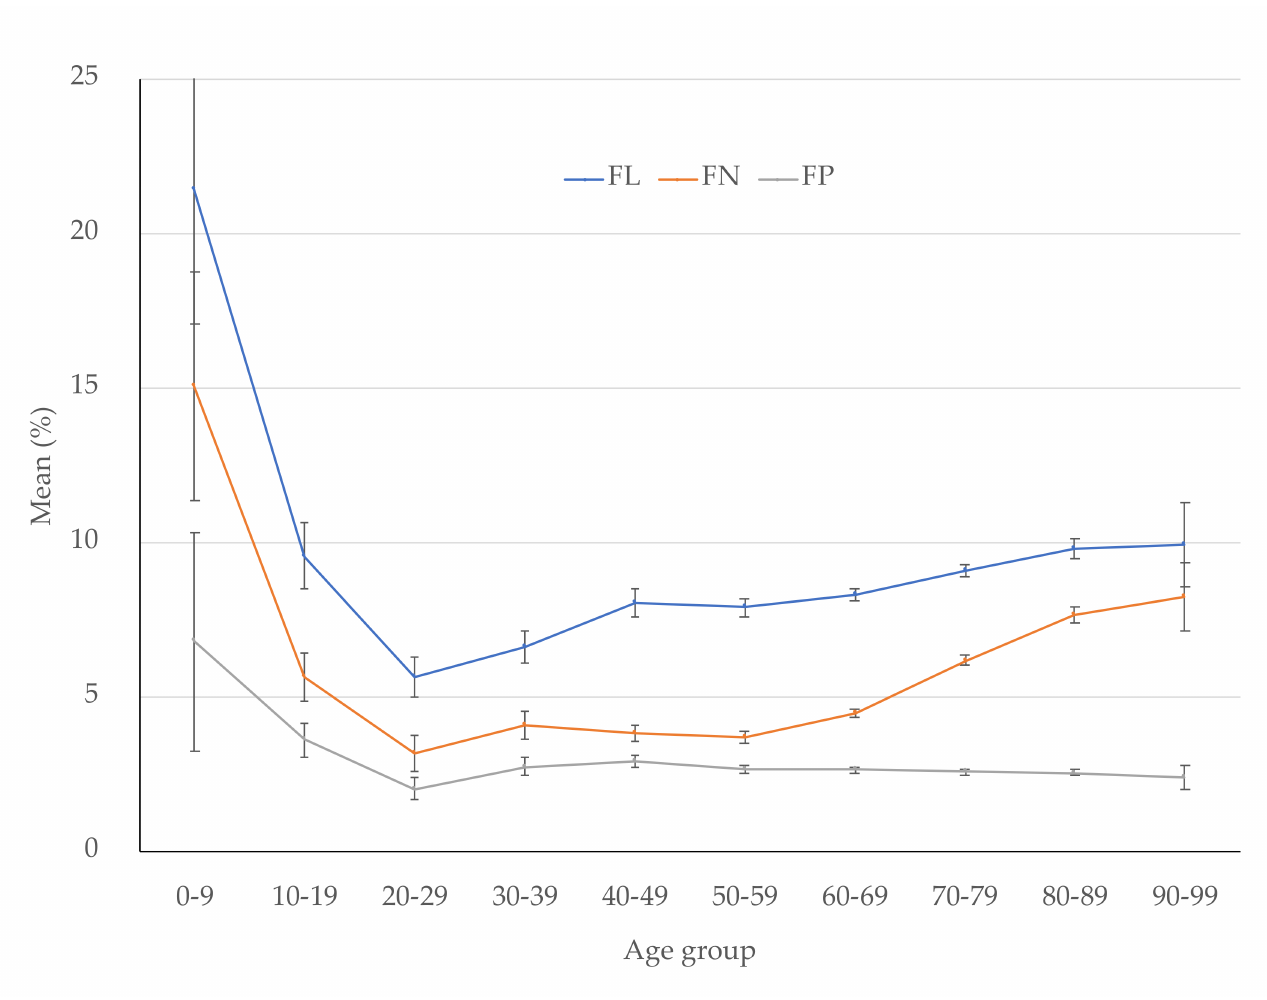
Figure 2. Mean values of FLs, FNs, and FPs in each age-stratified group. FL, fixation loss; FN, false negative; FP, false positive. Error bars indicate 95% confidence